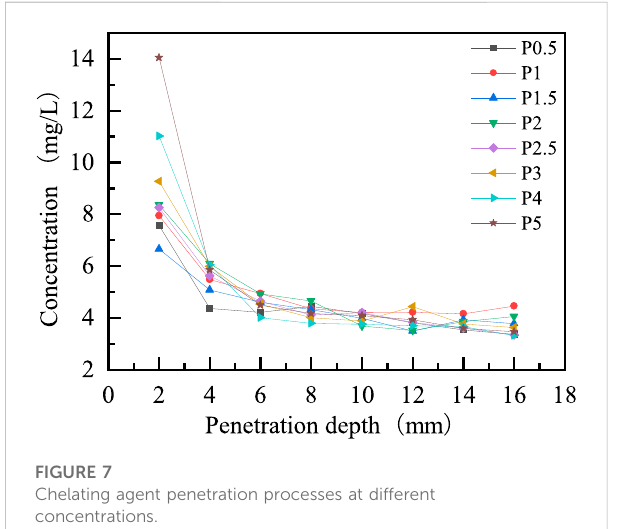
FIGURE 8 Comparison of chelated and non-chelated ion permeation